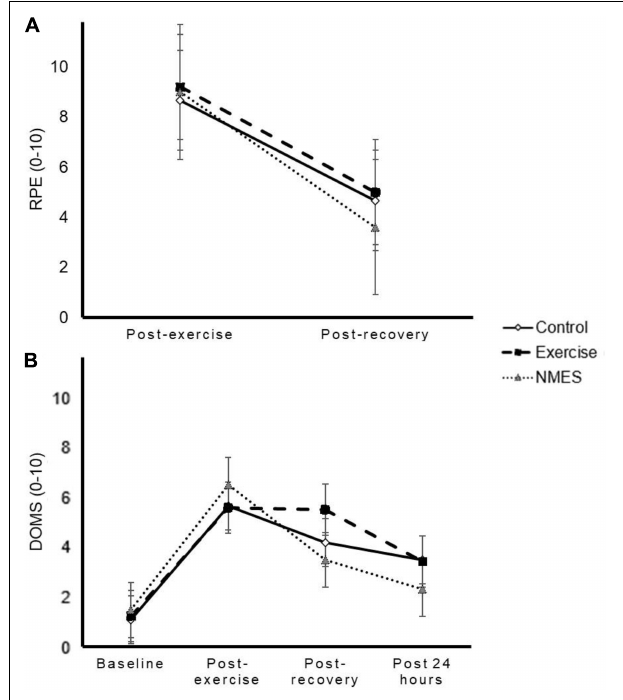
FIGURE 2 | Effects of low-intensity exercise (Exercise), surface neuromuscular electrical stimulation (NMES), or total rest (Control) on rating of perceived exertion (RPE, panel A ) and delayed-onset muscle soreness (DOMS, panel B ). A significant interaction effect was found for both variables ( p = 0.035 and p = 0.017, respectively), but post hoc analyses revealed no significant differences at any time